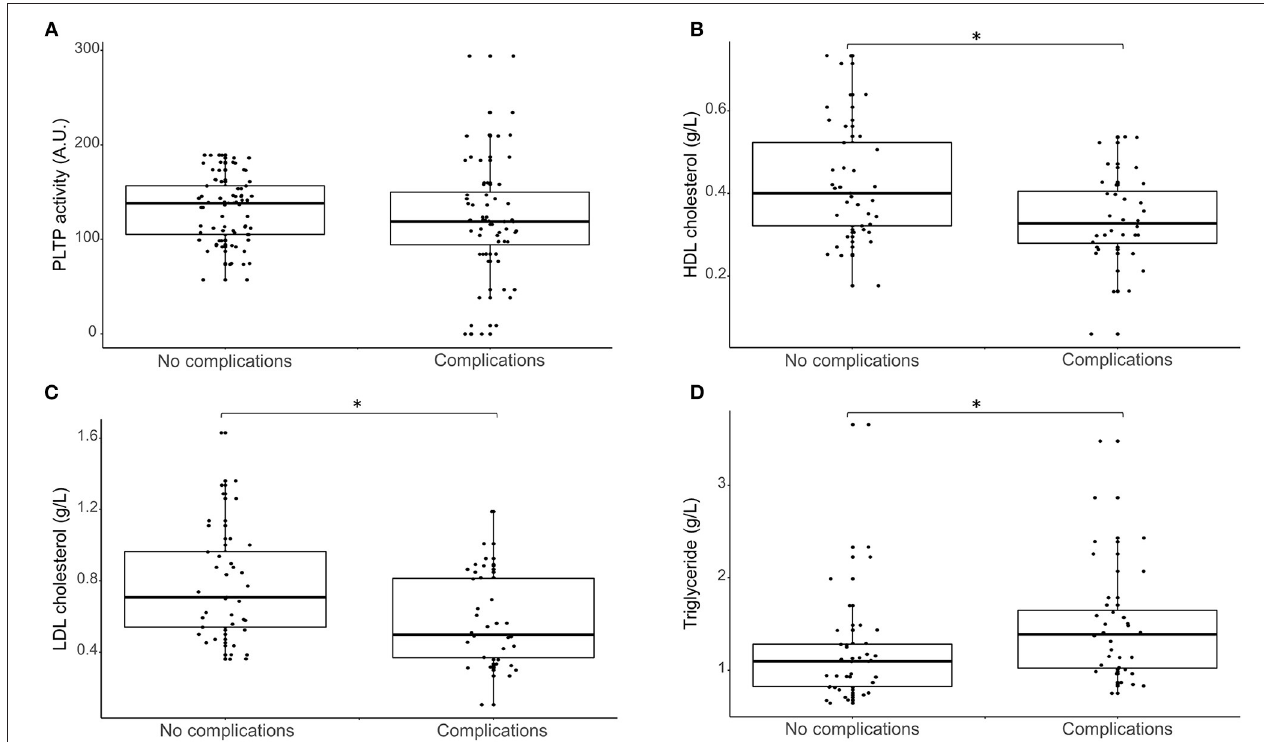
FIGURE 2 | Box plot representing the association between lipid parameters ( A : PLTP activity, B : HDL cholesterol concentration, C : LDL cholesterol concentration and D : Triglyceride concentration) at baseline and post-operative complications. PLTP, phospholipid transfer protein; HDL, High density lipoprotein; LDL, low density lipoproteins. *significant differences ( p -value <